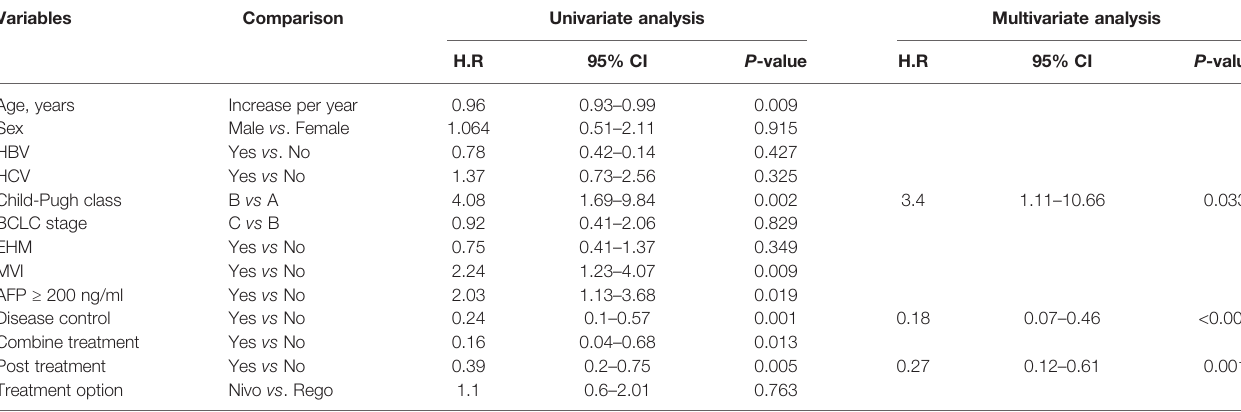
TABLE 3 | Univariate and multivariate Cox regression analyses for overall survival.